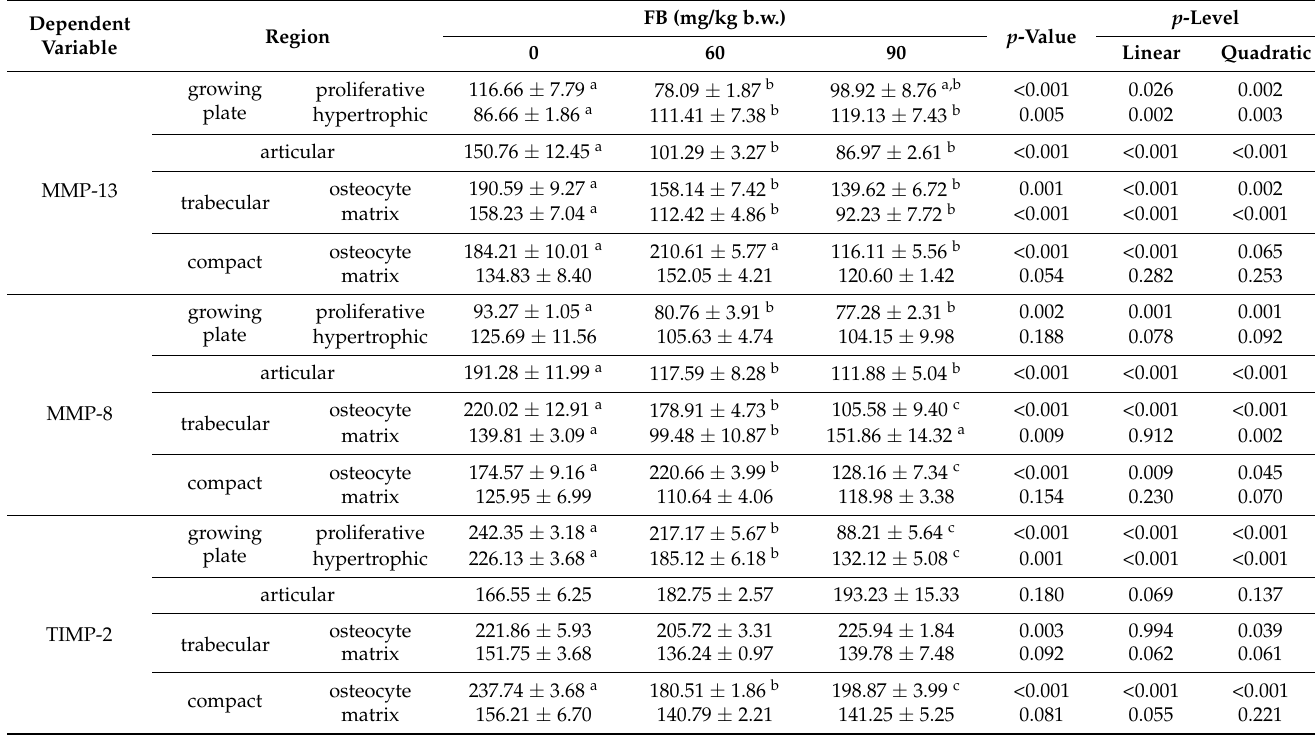
Table 2. The intensity of MMP-13, MMP-8 and TIMP-2 immunoreaction in bone and articular tissue of female rat offspring following maternal exposure to 0, 60 and 90 mg/kg b.w. of